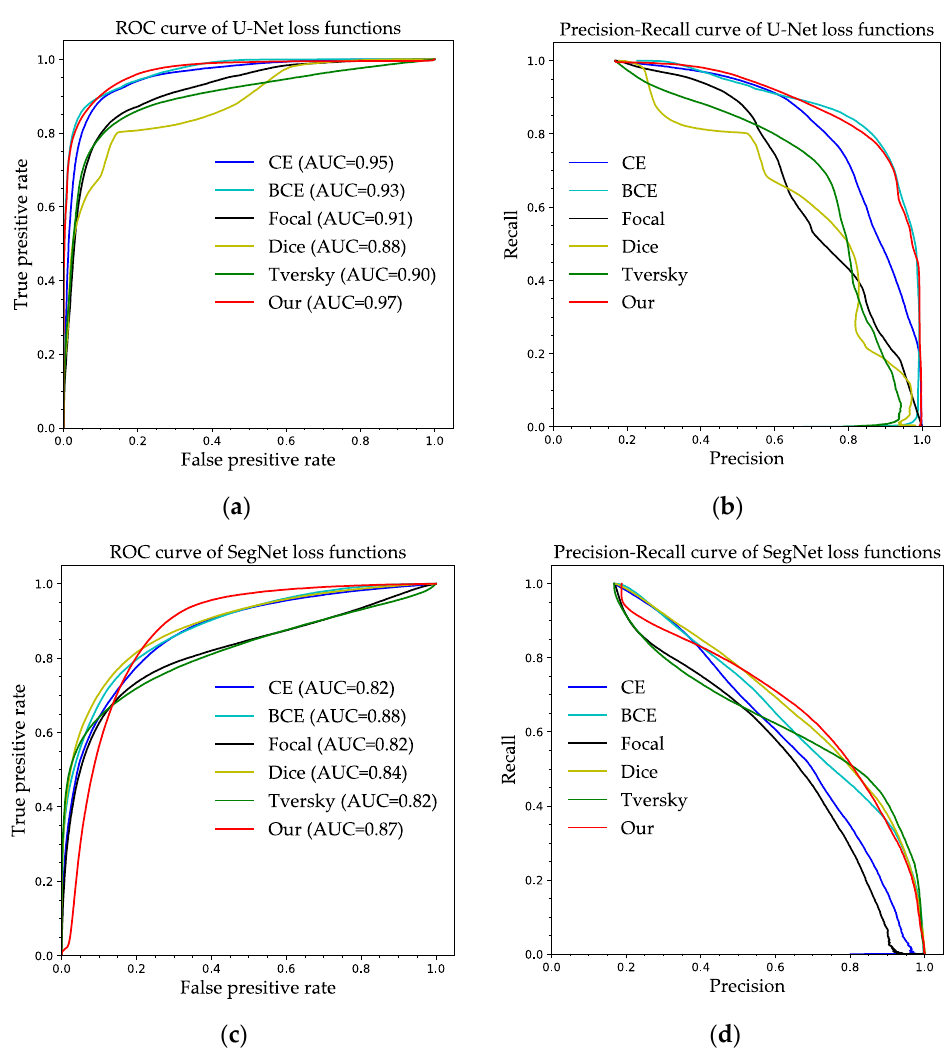
Figure 15. ROC and P–R curves to evaluate the ability of U-Net ( a , b ) and SegNet ( c , d ) to segment the water column using different loss functions.